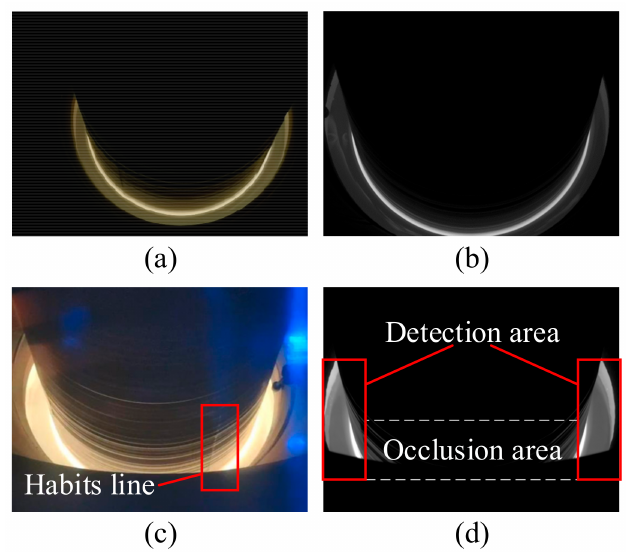
Figure 3. Color and grayscale images of the furnace body in the cylindrical growth step ( a , b ) without occlusion; ( c , d ) with